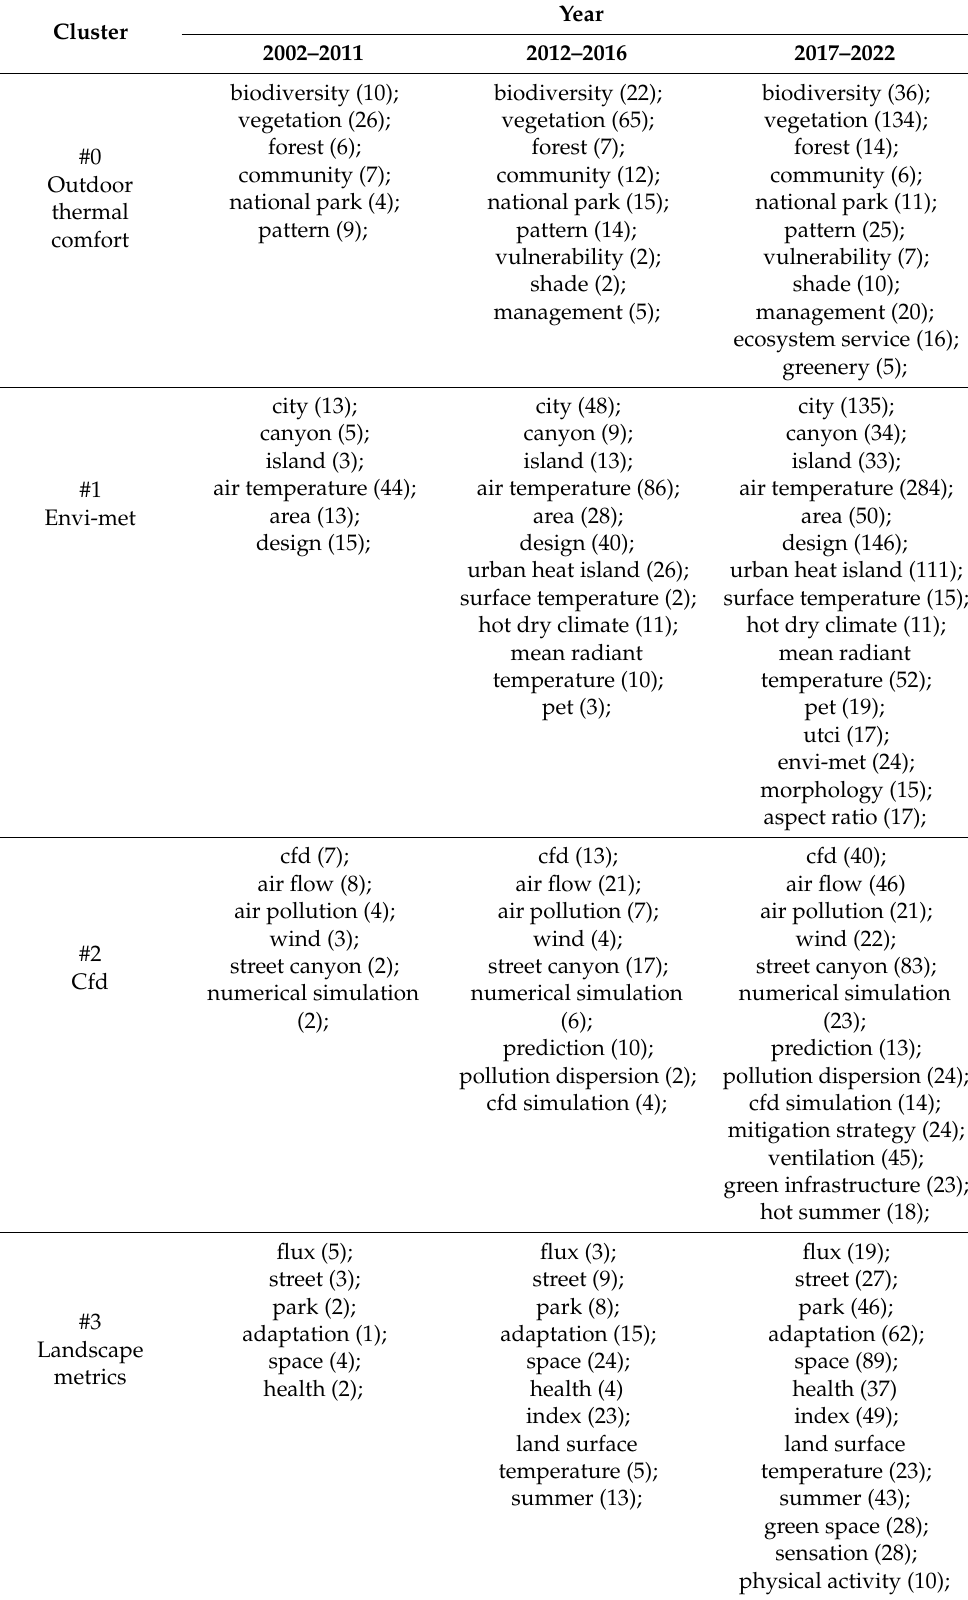
Table 3. Clustering and temporal evolution of high-frequency keywords in other countries.